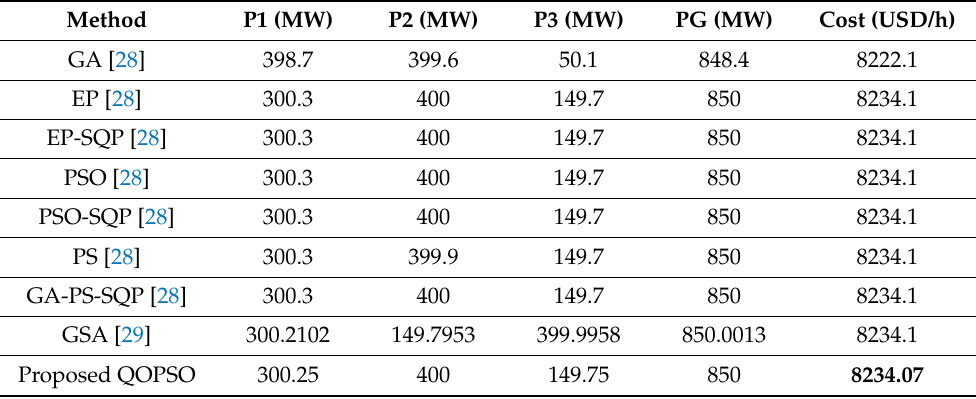
Table 1. Comparison of power distribution among three units for the load demand of 850